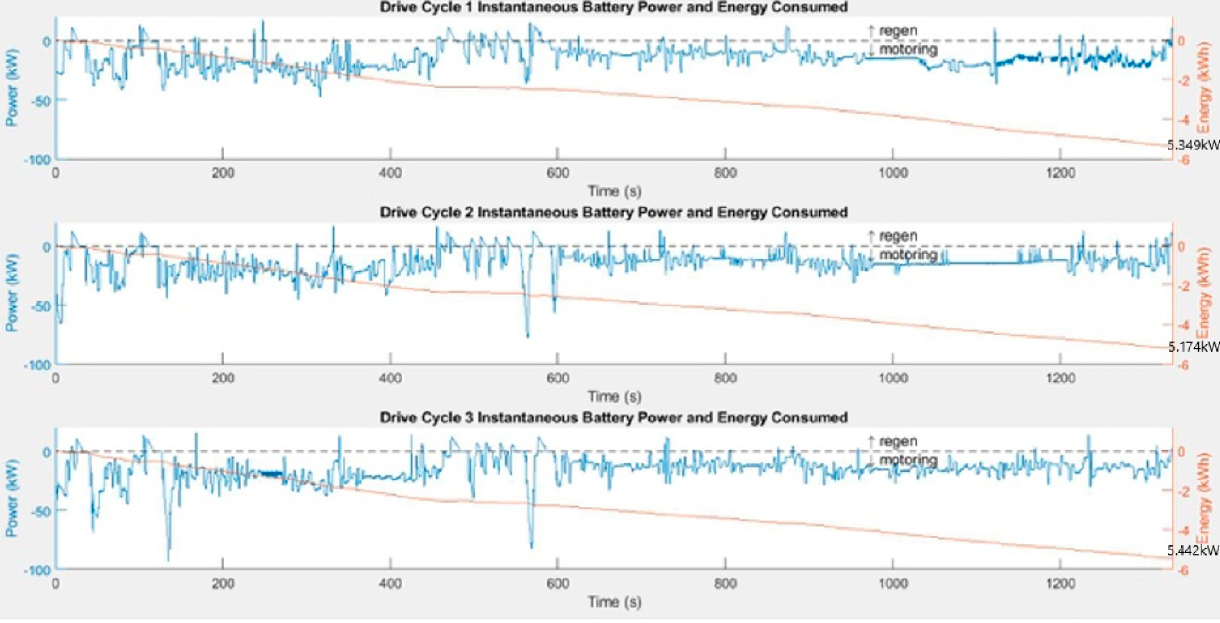
Figure 18. MCT drive cycle vehicle power (left axis) and energy (right axis) on chassis dynamometer Adapted from [18], IEEE: 2020.